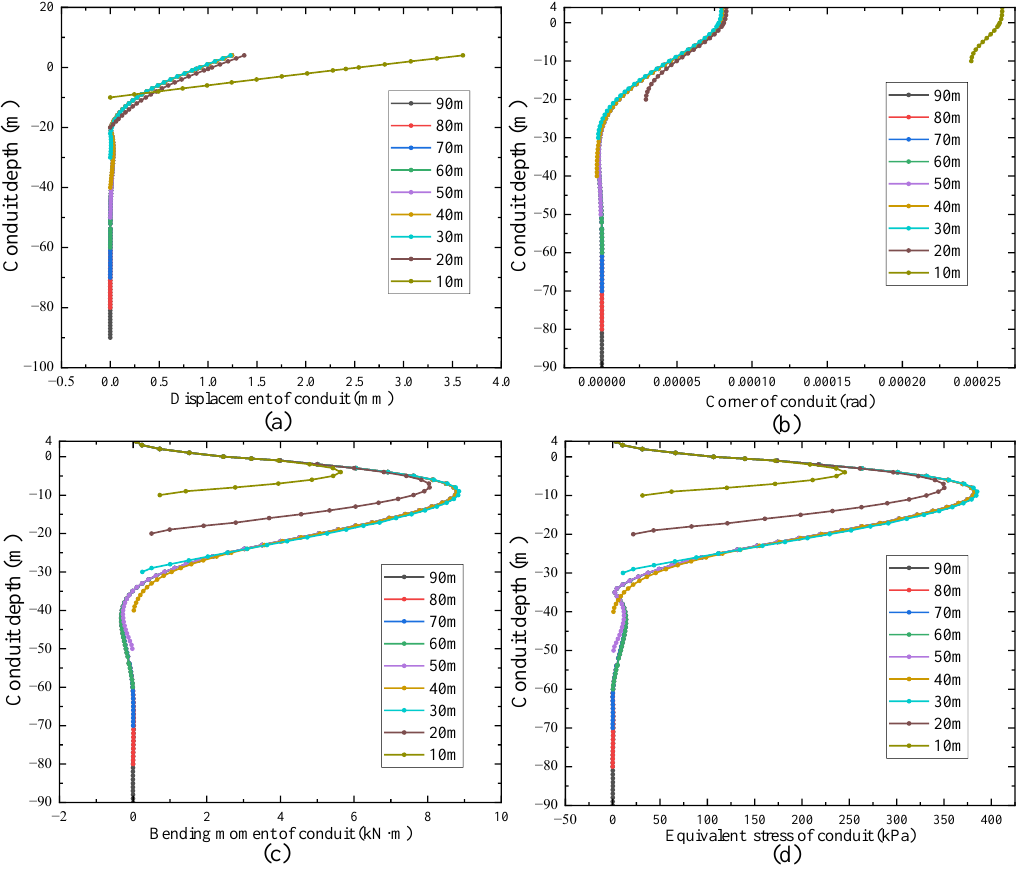
Figure 7. ( a ) Effect of driving depth on conductor displacement, ( b ) Effect of driving depth on conductor turning angle, ( c ) Effect of driving depth on conductor bending moment, ( d ) Effect of driving depth on conductor equivalent force.